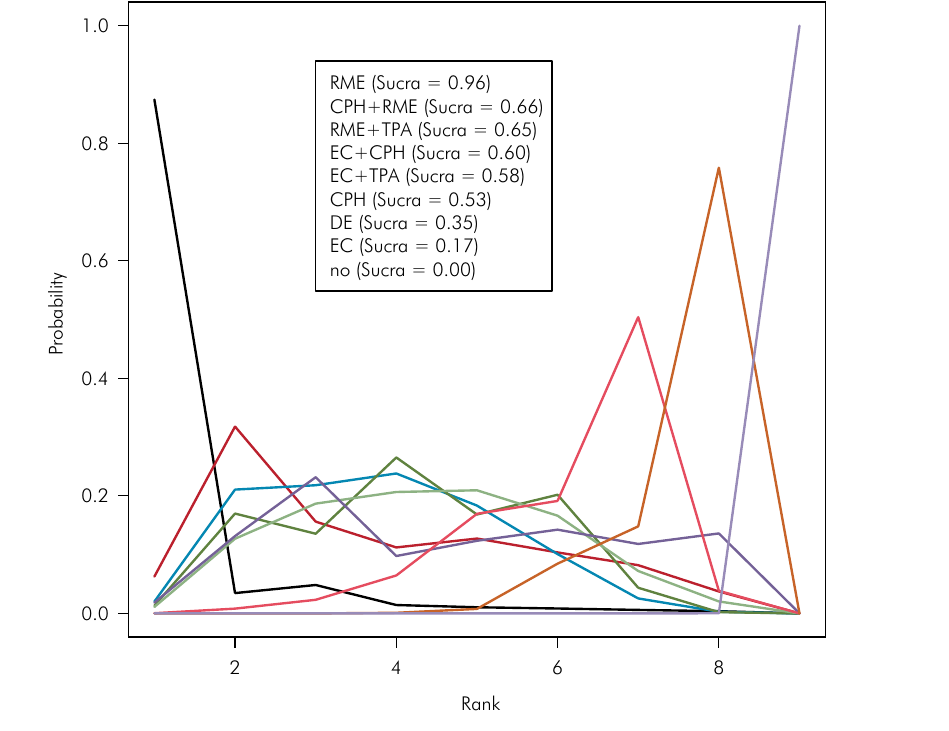
Figure 4. Rankogram and SUCRA for success rate of eruption of displaced permanent